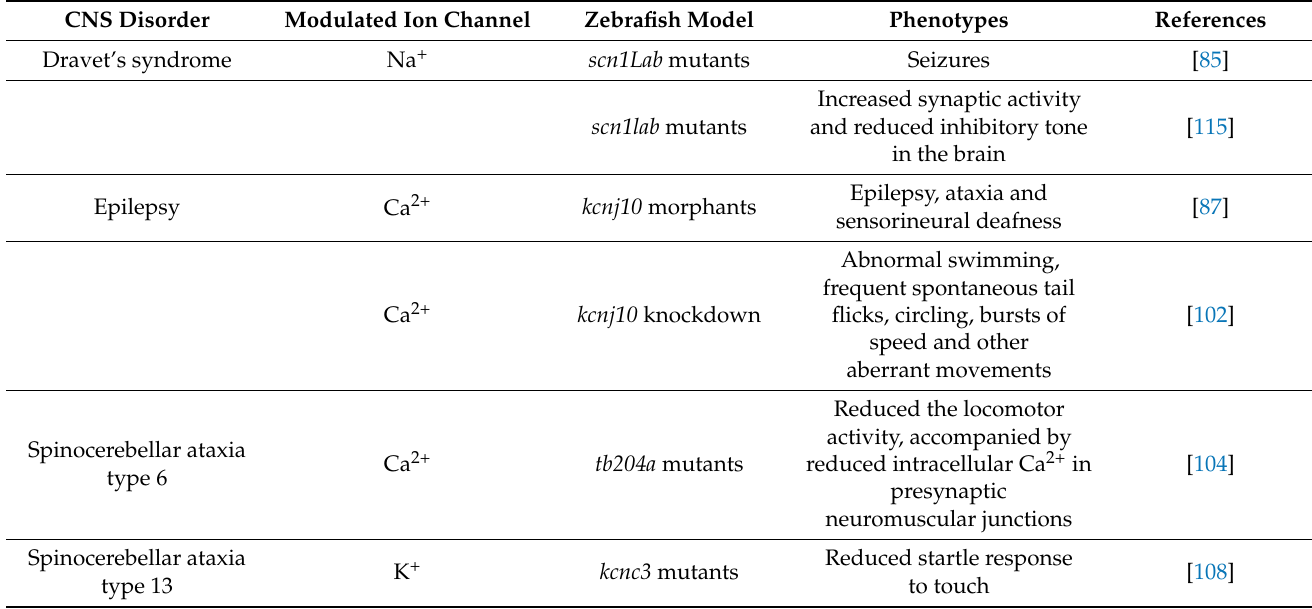
Table 4. Selected zebrafish models of CNS